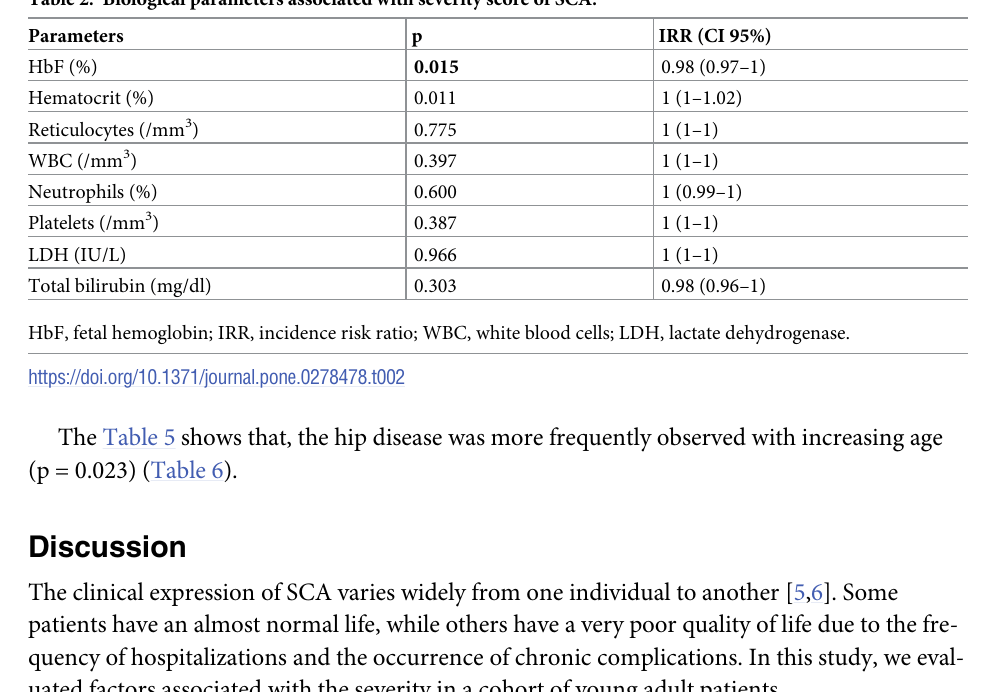
Table 2. Biological parameters associated with severity score of SCA.